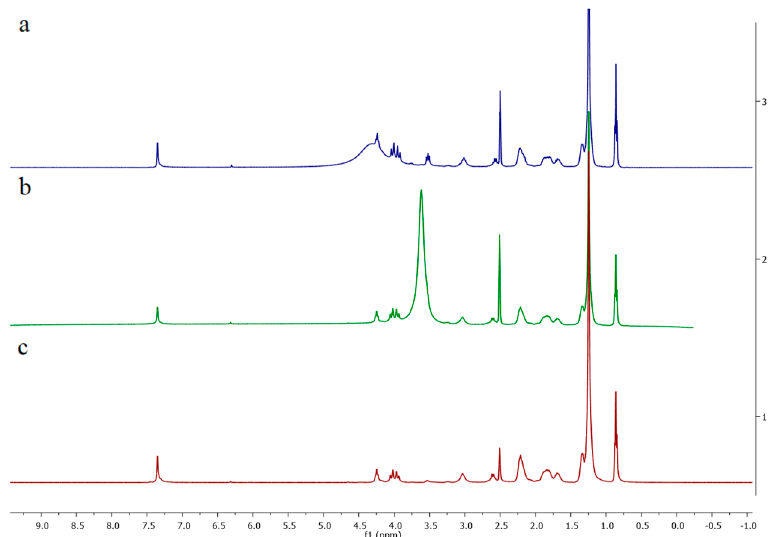
Figure 2. 1 H-NMR spectra (400 MHz, DMSO- d 6 , 323 K) of compound 6 . ( a ) Conventional, ( b ) adding D 2 O, and ( c ) suppressing the residual signal of D 2 O.